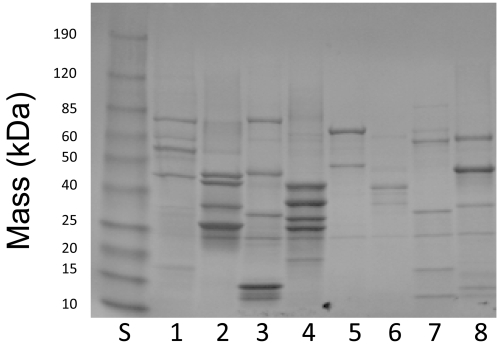
SDS-PAGE gel of production of pooled protein.Sets of 6–8 genes were moved in pools from pDONR entry plasmids into pDEST-PTD4 via a Gateway LR reaction (Invitrogen) and the resulting plasmids transformed into BL21(DE3)pLysS cells for protein production. Recombinant HIS-tagged proteins were purified on Co+2 affinity resin and the bound proteins analyzed by SDS-PAGE. Protein pools depicted in lanes 1–5 were generated from the pooling of 8 genes, while lanes 6, 7 and 8 were derived from 7, 6, and 6 genes respectively. Lane “S” contained molecular weight standards (BenchMark Prestained Protein Standard; Invitrogen). Overall, approximately 80% of genes yielded proteins when expressed as pools.